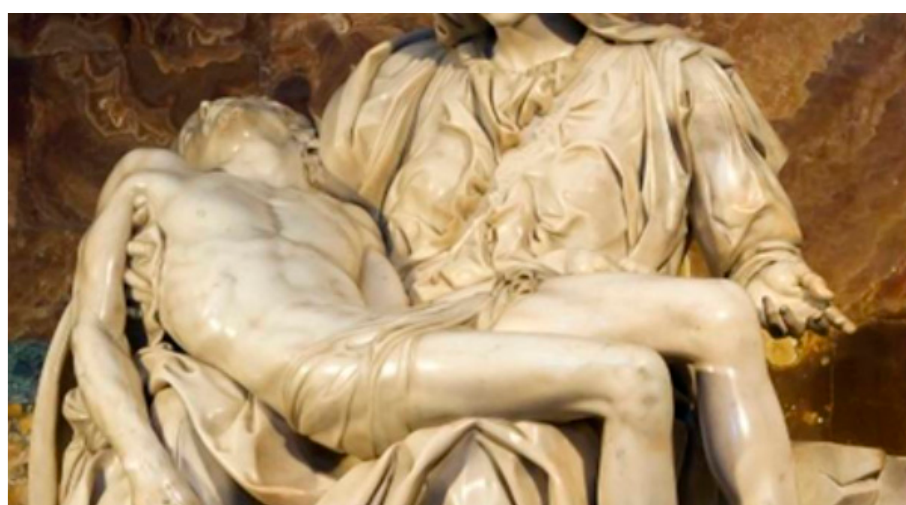
Figure 11. Cross-legged posture in Michelangelo´s Pietá. A close-up view of a section.